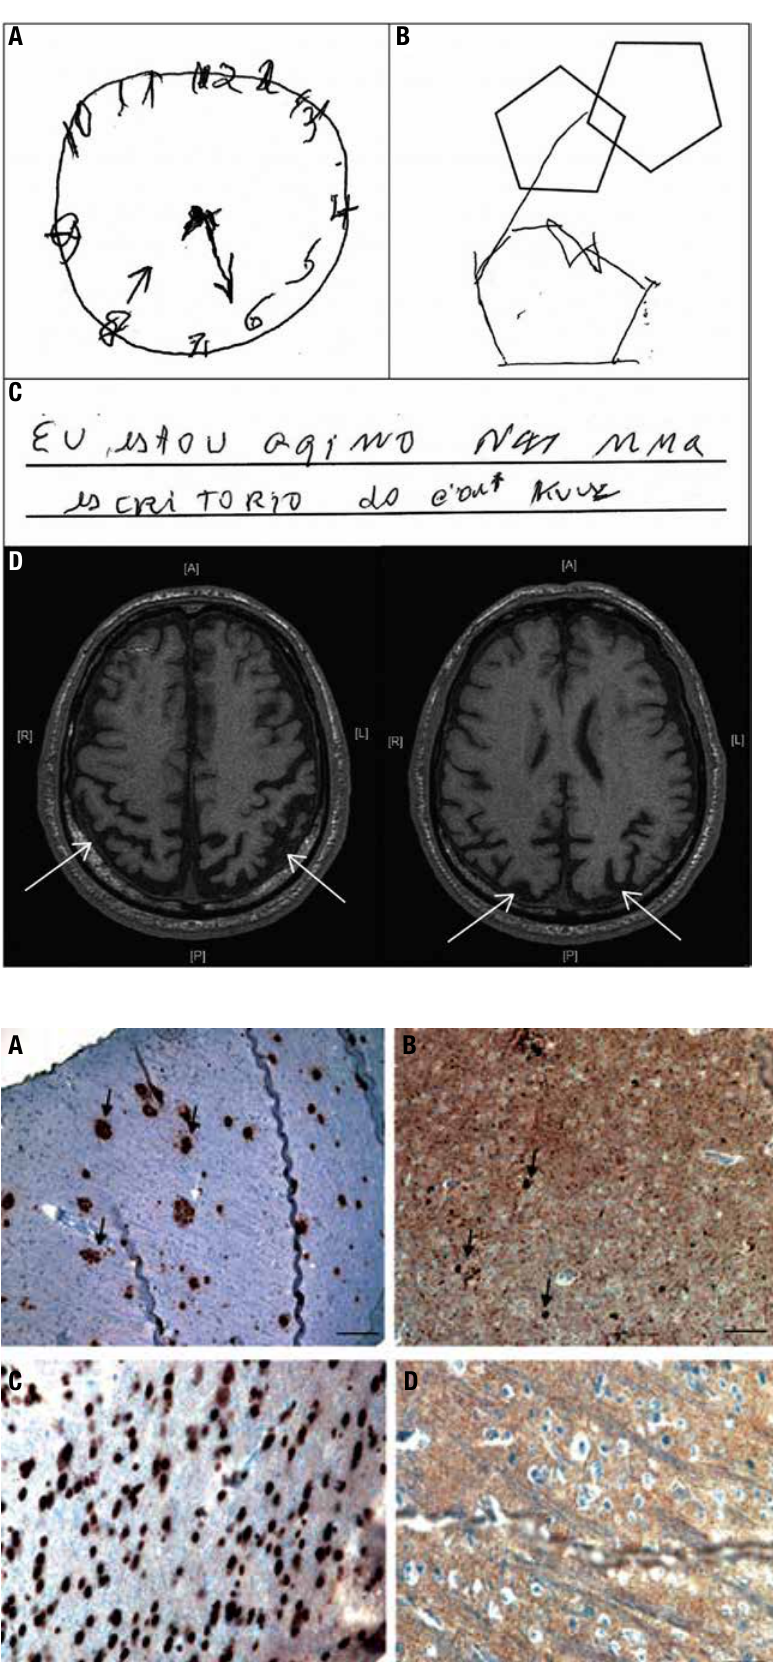
figure 2. Immunohistochemistry of biopsied parietal